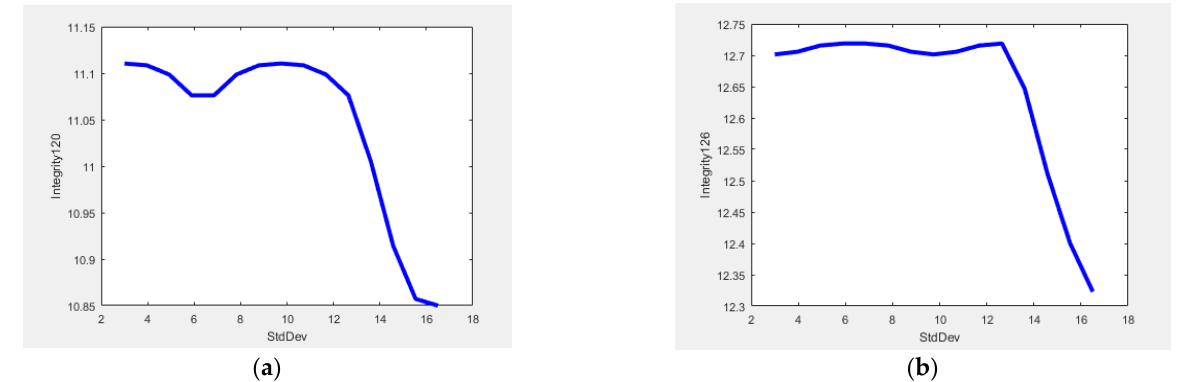
Figure 6. The SSN standard deviation ( x 2 ) and the integrity of PRN120 ( a ) and PRN126 ( b ) (Own study in MATLAB Fuzzy Logic Toolbox).